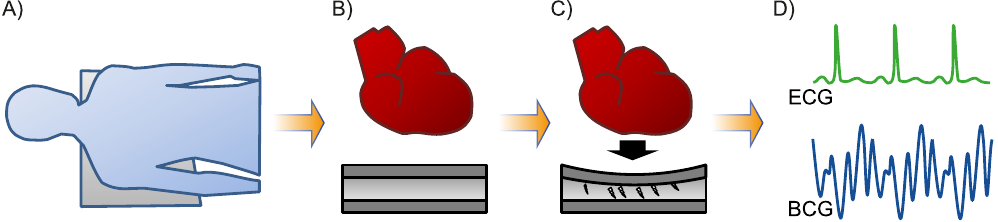
Figure 1. BCG measurement and correlation with a synchronized recorded ECG. ( A ) BCG foil is positioned under the patient ’ s chest. ( B , C ) Mechanical cardiac activity induces a charge shift in the BCG foil. ( D ) A BCG signal is recorded and compared to a simultaneously recorded ECG.